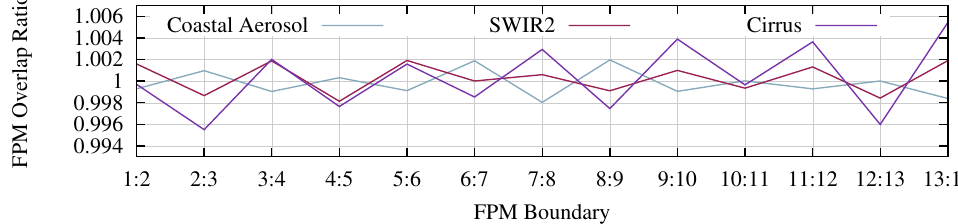
Figure 13. Focal plane module overlap ratios for the coastal aerosol, SWIR 2, and cirrus bands indicate a residual odd/even error between